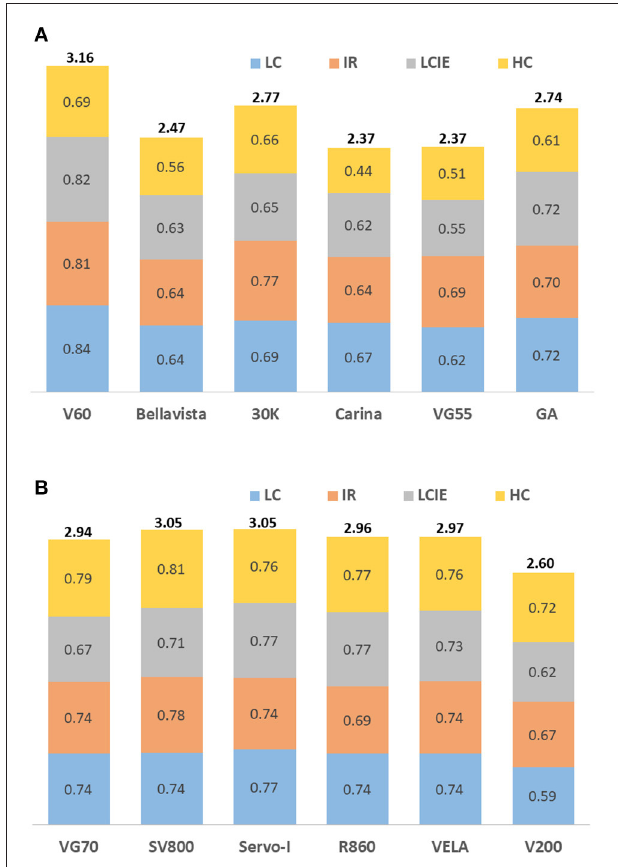
FIGURE 3 | Overall performances of the ventilators under three simulated COVID-19 phenotypes. IR, increased airway resistance; LC, low compliance; LCIE, low compliance plus increased respiratory effort; HC, high compliance. (A) non-invasive ventilators with single-circuit connection. (B) ICU ventilators with non-invasive ventilation mode and double-circuit